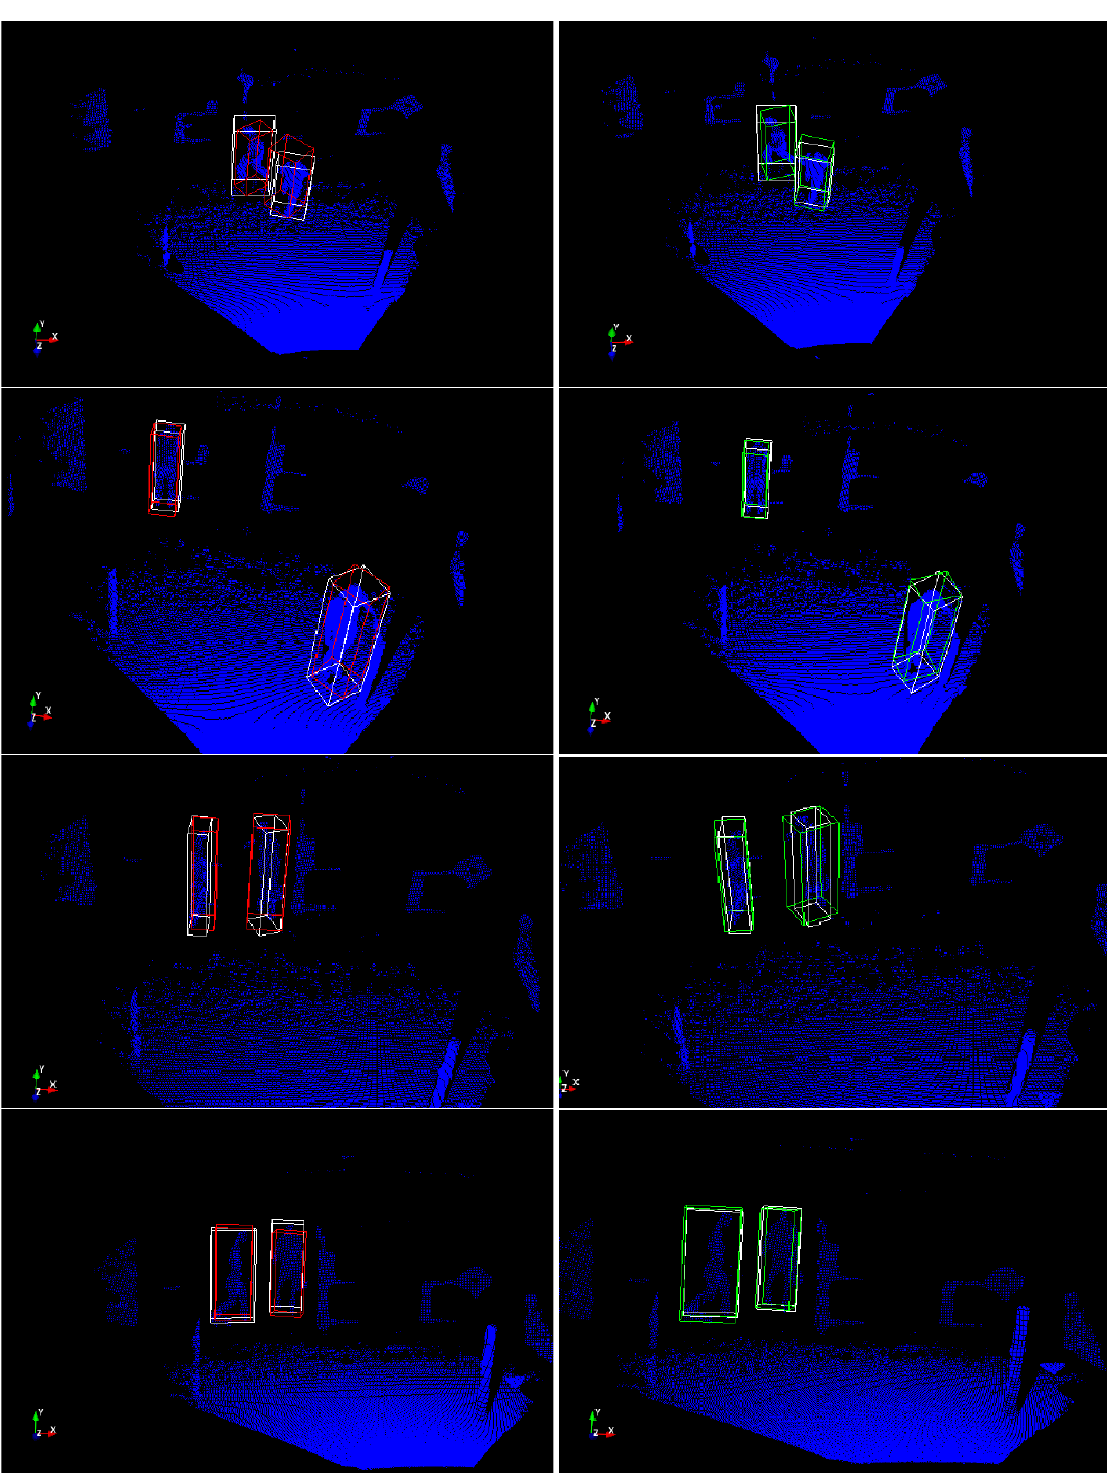
Figure 7. Qualitative comparison of pedestrian 3D detection results using baseline (red bounding boxes on the left) and our proposed approach using ODR features (green bounding boxes on the right). The white bounding boxes are the manually annotated ground